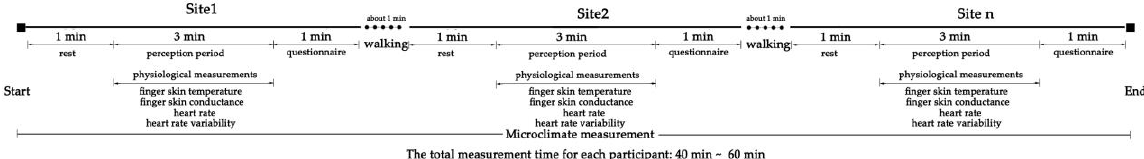
Figure 2. Experiment protocol.